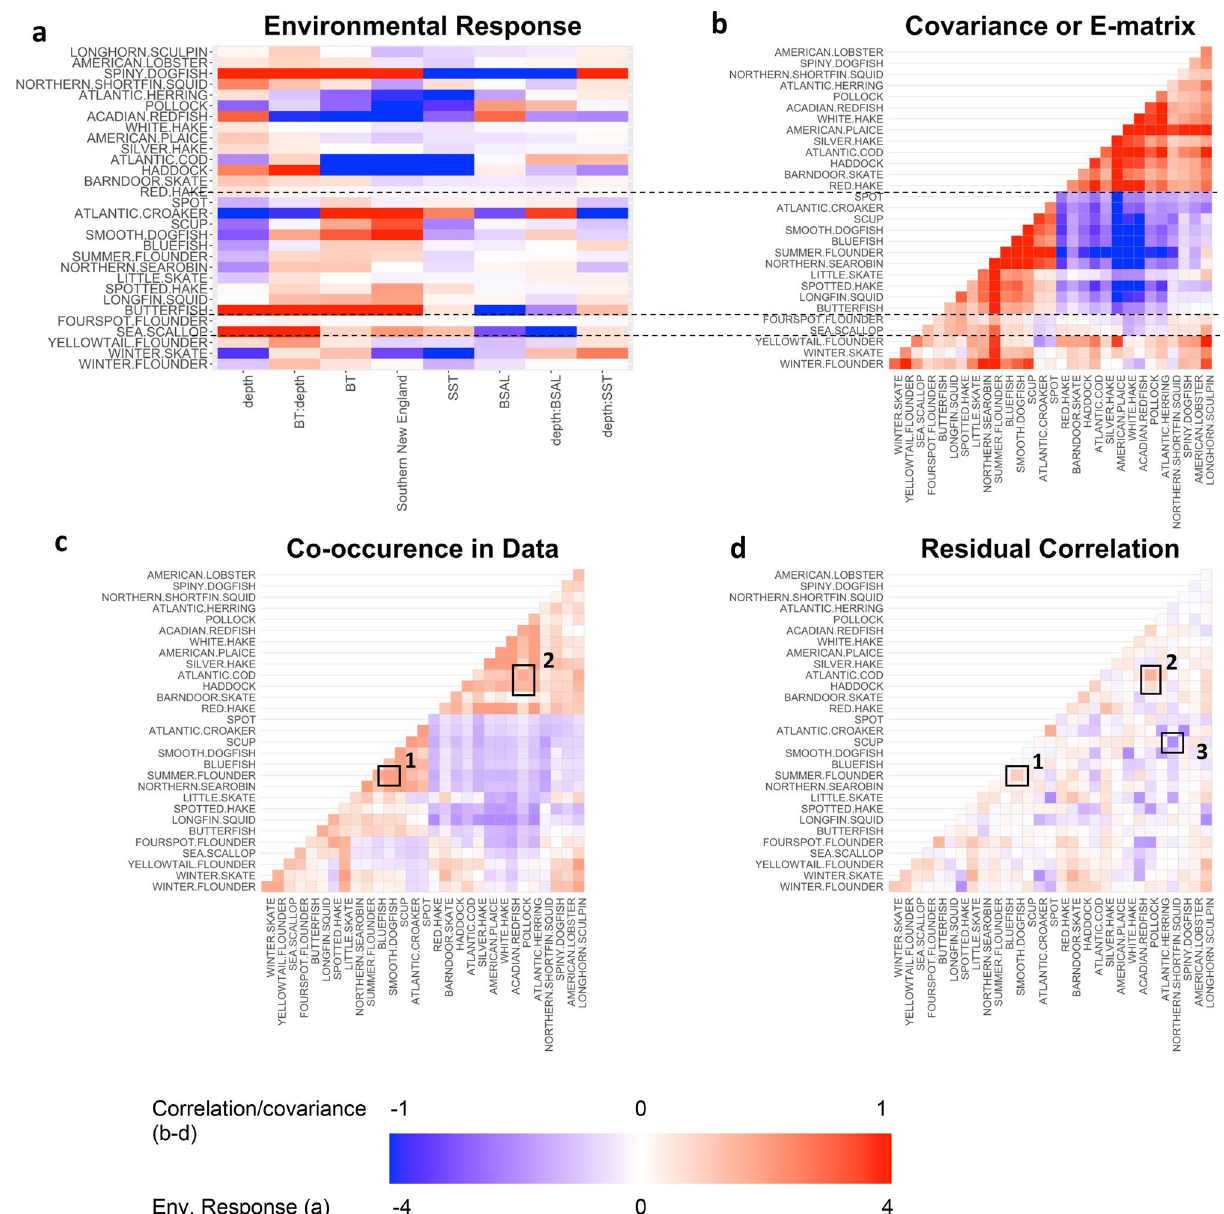
Figure 3. Model covariance results for the fall CPUE. ( a ) Coefficients for the species-environment responses (from fitted model), β . ( b ) Covariance between species in how they respond to the environment, E . ( c ) Species co-occurrence in catch data. ( d ) Residual correlation from the fitted model, R . Boxes highlight species discussed in the text. Environmental response of factor variable ( a ), subregion is compared to the baseline level (Gulf of Maine). Figure was created using the ggcorrplot (Version 0.1.3.999; http:// www. sthda. com/ engli sh/ wiki/ ggcor rplot) and corplot (Version 0.84; https:// github. com/ taiyun/ corrp lot) packages in